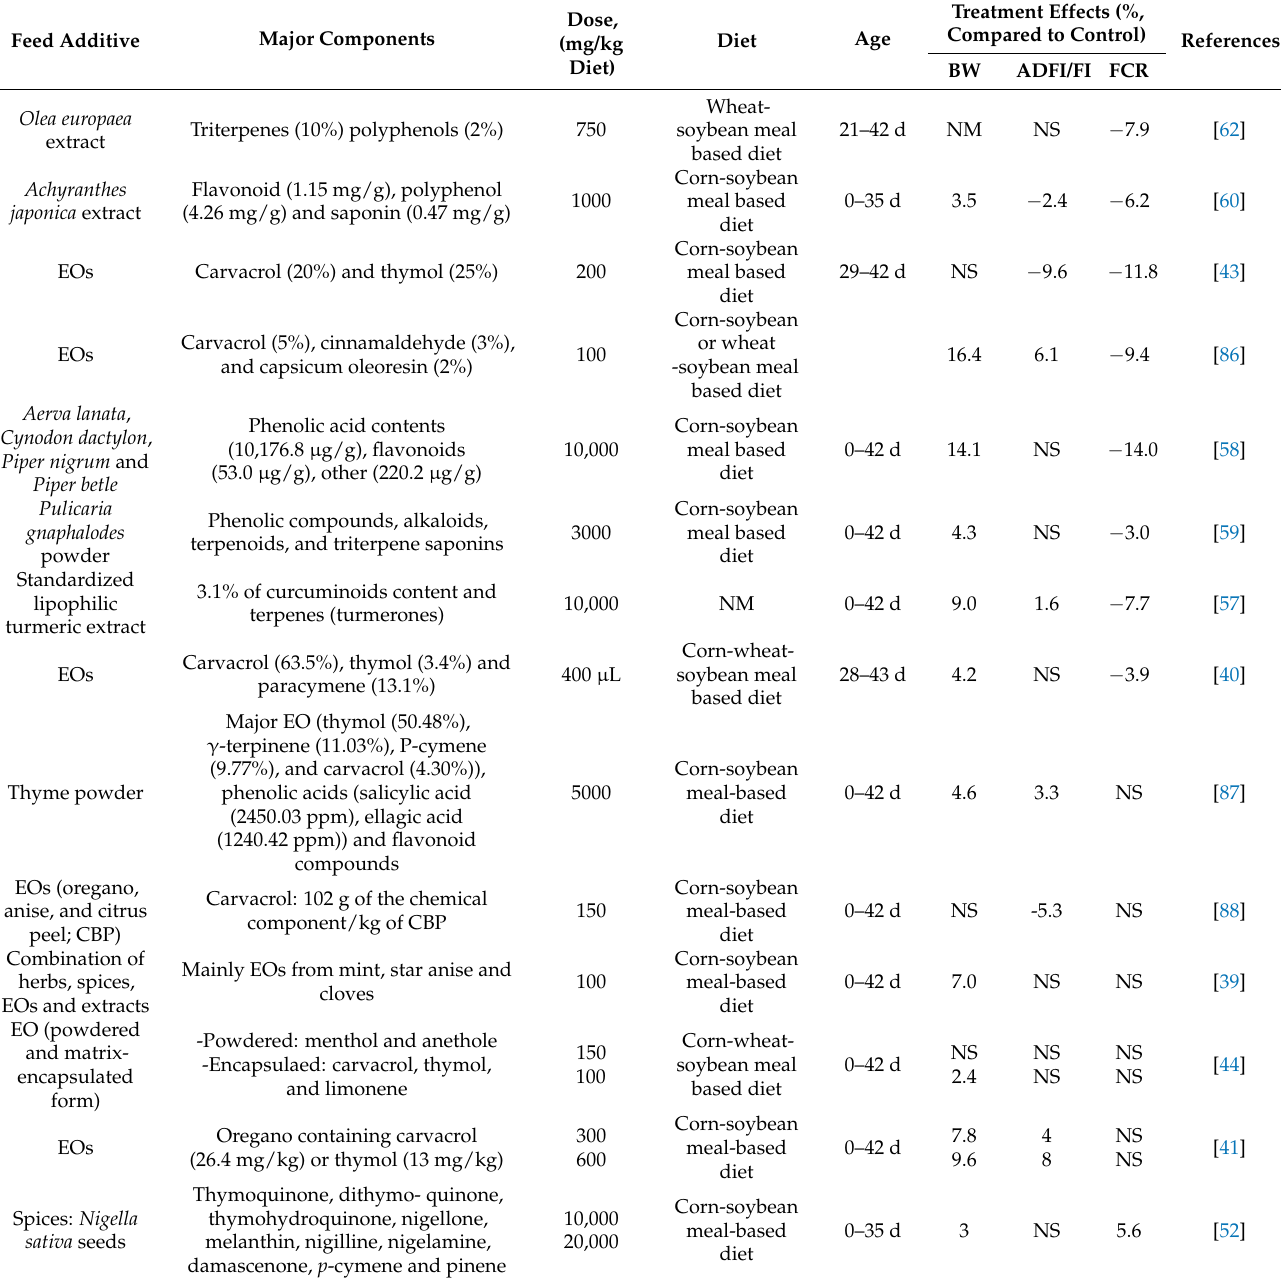
Table 1. Effects of dietary supplementation of PFAs on growth performance of broilers under non-challenging conditions.